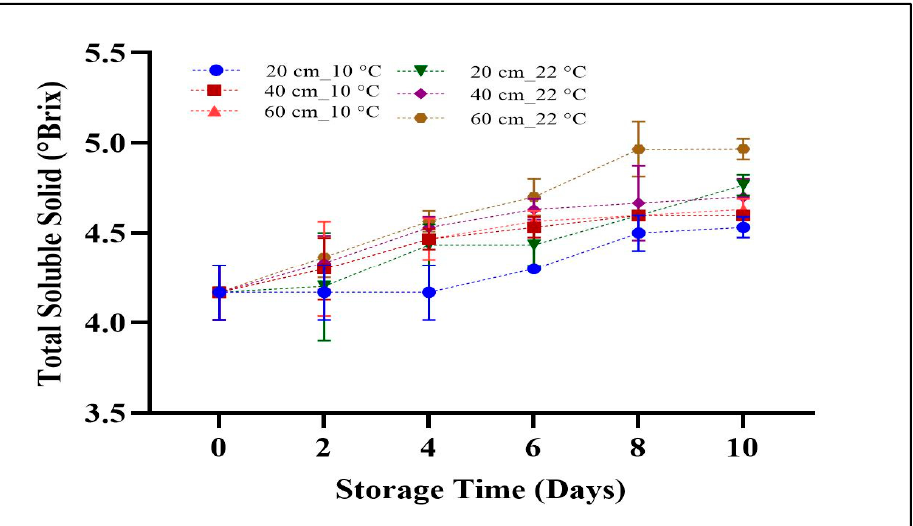
Figure 10. TSS of tomatoes impacted at different drop heights (20 cm, 40 cm, and 60 cm) and stored for 10 days in 10 °C and 22 °C storage conditions. Error bars represent the standard deviation (SD) of the mean values ± S.D. of six readings of three replicates.